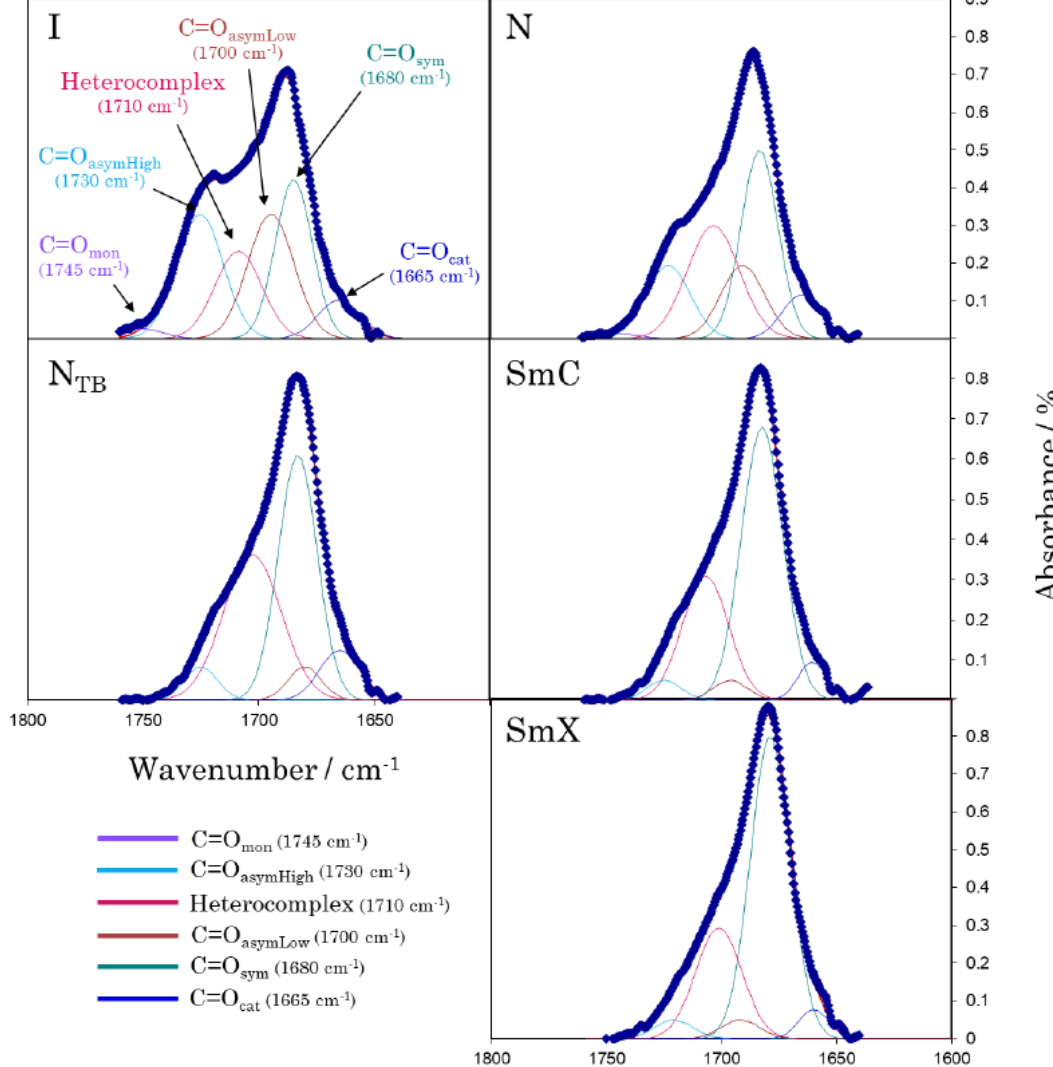
Figure 10. Deconvolution of the carbonyl stretching region for the CB6OBA:4OS equimolar mixture obtained in the isotropic (195 °C), nematic (150 °C), twist-bend nematic (95 °C), smectic C (80 °C) and smectic X (55 °C) phases.